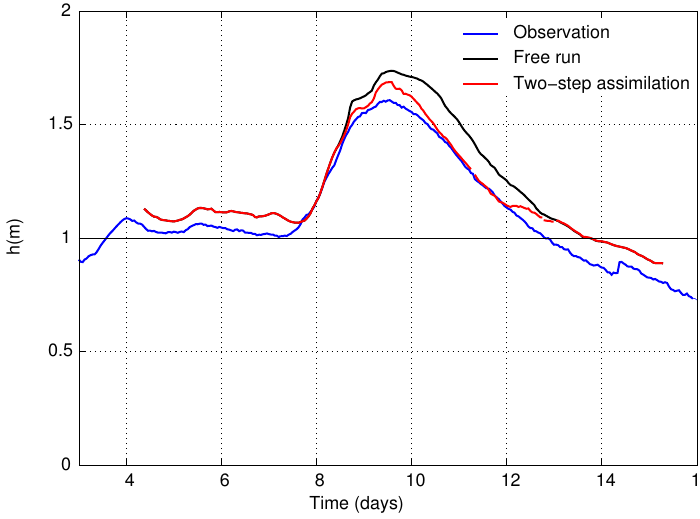
Fig. 12. April 2006 event, Marne Vallage catchment. Six-hour forecasted water level at Joinville for the Free run (black curve), the observation (blue curve) and the Assim run (red